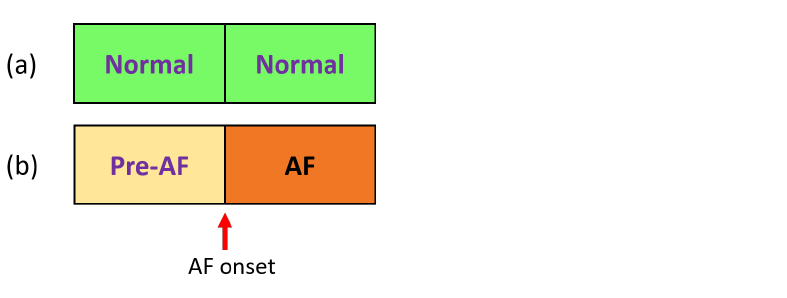
Figure 1. AF prediction schematic. ( a ) Normal recordings followed by normal recordings (control group). ( b ) Pre-AF (i.e., normal) recordings followed by AF